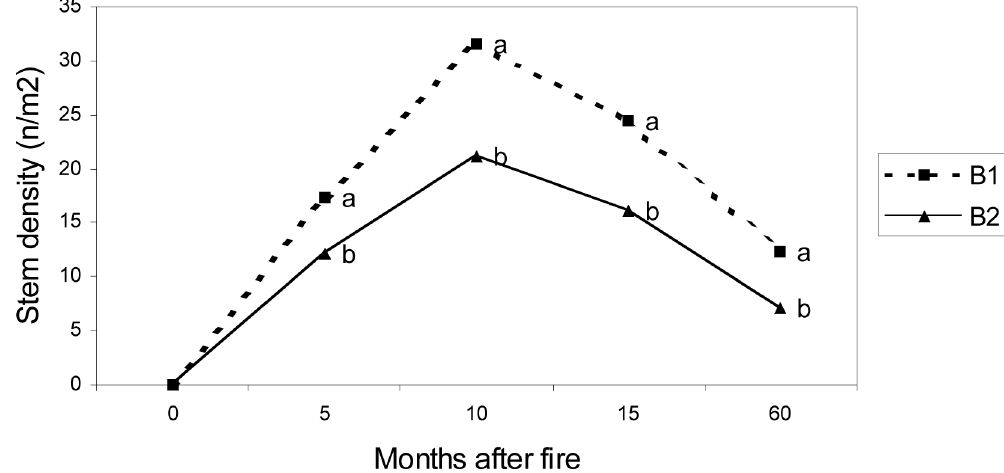
Fig. 1. Post-fire vegetation density changes in 5 years after the fire. B1 = once-burnt areas, B2 = twice-burnt